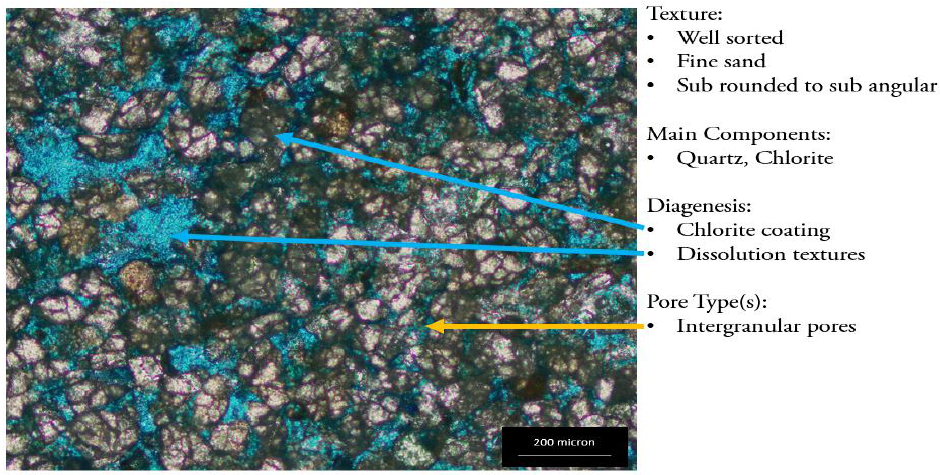
Figure 13. Textural and compositional features of L802 Belait.